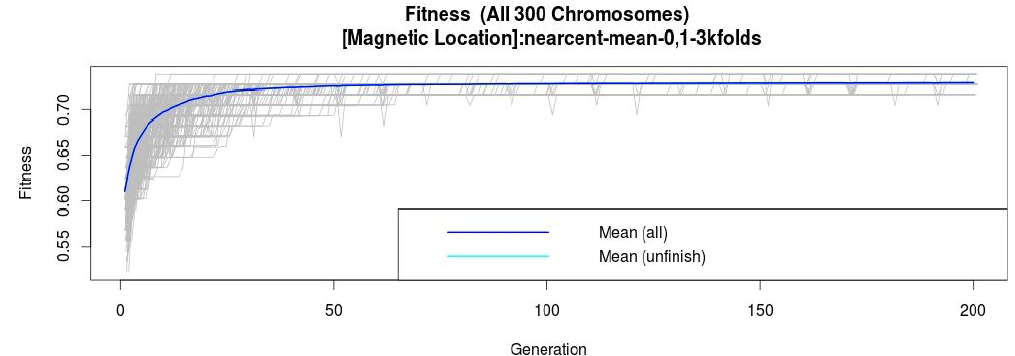
Figure 3. Magnetic field summer dataset evolution of the 300 nearest centroid models throughout 200 generations.